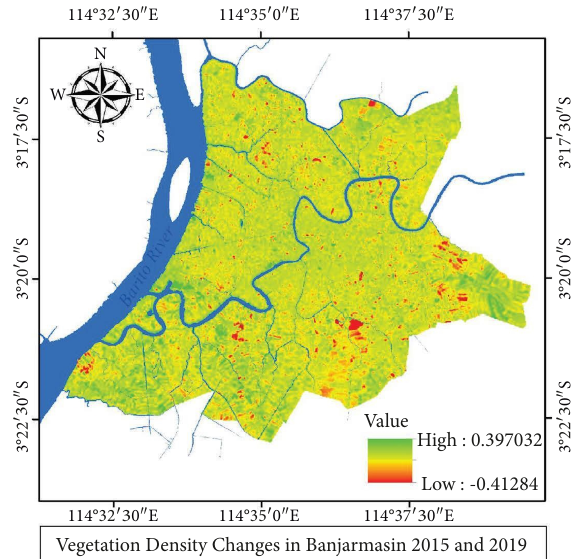
Figure 4: Changes in vegetation density in Banjarmasin City in 2015 and 2019.